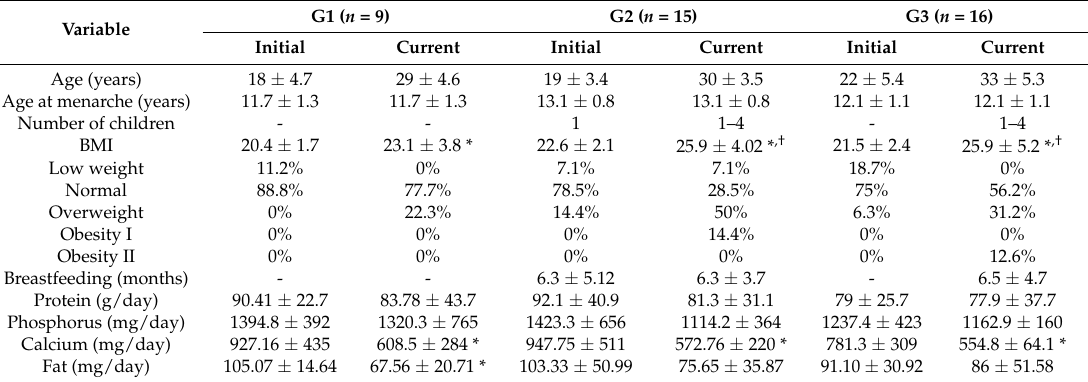
Values are mean ± SD. Paired t test for normal variables. † Wilcoxon test for non-parametric variables. G1: nulliparous women; G2: mothers 12 years ago; G3: nulliparous 12 years ago but now mothers. BMI: body mass index. * Significant differences at p ≤ 0.05.